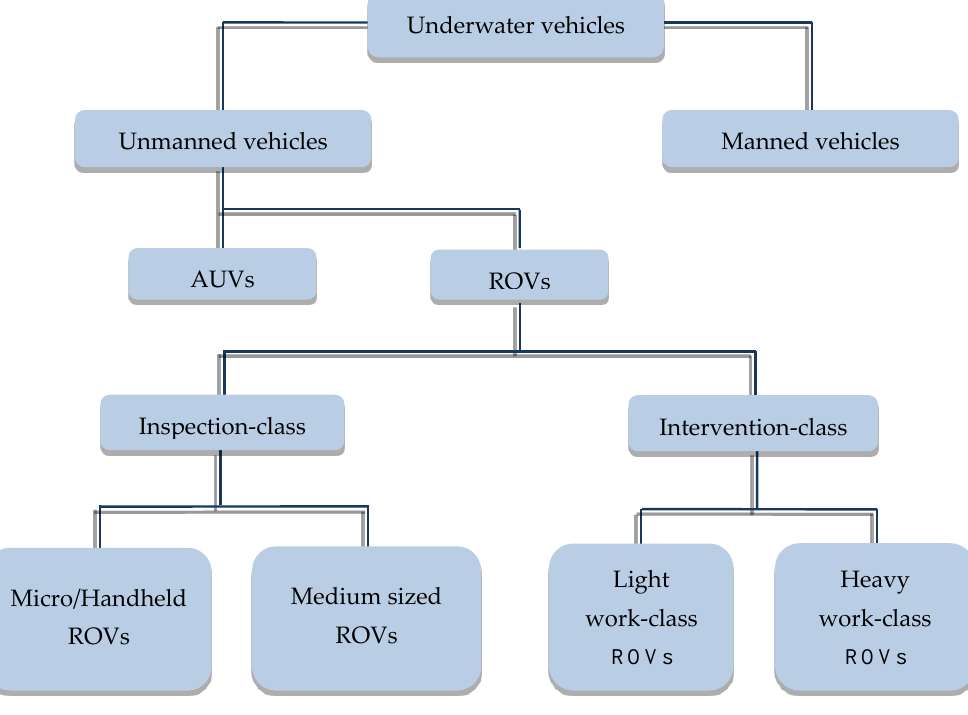
Figure 1. Outline of underwater vehicles.